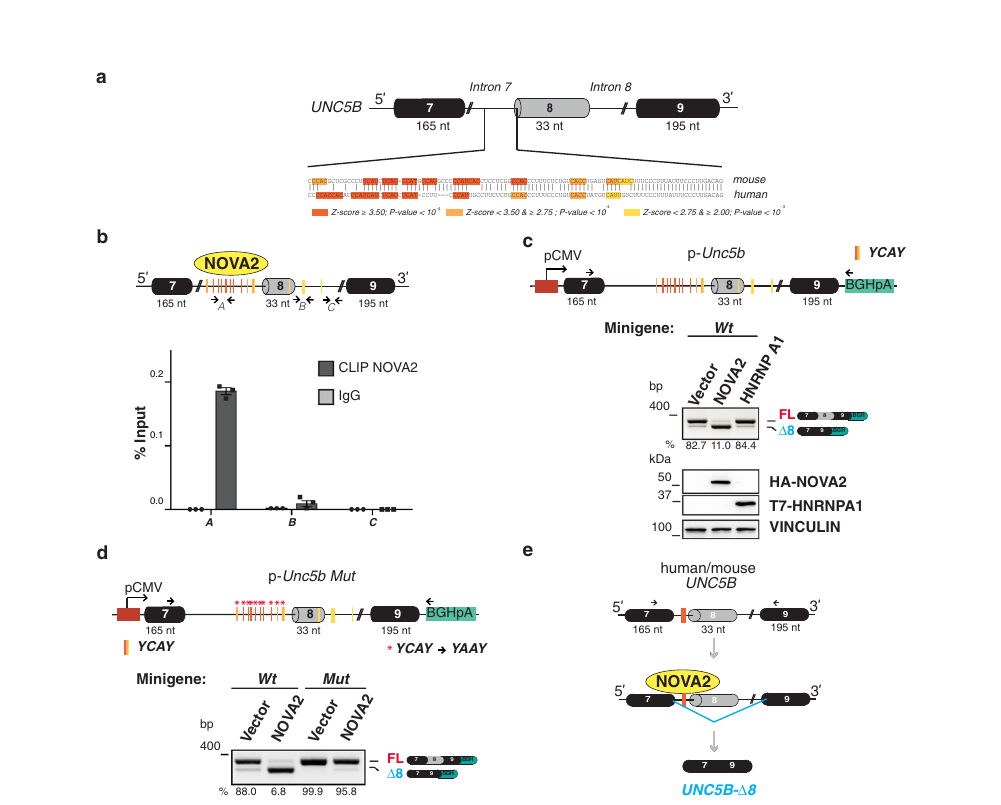
Fig. 2 NOVA2 directly binds to Unc5b pre-mRNA. a Schematic representation of mouse and human UNC5B pre-mRNAs. AS exon 8 in gray. Constitutive exons 7 and 9 in black. Introns 7 and 8 are also indicated (thin lines). YCAY sites, identi fi ed by using the RBPmap tool within 200 nt from the exon – intron junctions, are indicated in orange, pale orange, or yellow bars depending on their Z-score and P values (calculated by RBPmap tool). b Upper: schematic representation of mouse Unc5b as in a . Arrows indicate primers used for RT-qPCR of NOVA2 immunoprecipitated RNAs. Lower: RT-qPCR of NOVA2 CLIP experiments in moEC. Ampli fi cation of immunoprecipitated RNAs with primers annealing to the YCAY cluster in intron 7 (A ) and, as negative controls, within intron 8 ( B and C ). Error bars indicate ±SD calculated from n = 3 independent experiments. c Upper: the mouse Unc5b genomic region encompassing exons 7, 8, and 9, cloned into the pcDNA3.1( + ) vector to generate the p- Unc5b wild-type ( Wt ) minigene. Arrows indicate primers used for splicing analysis of the transcripts generated from the minigene. Boxes = exons; thin lines = introns; pCMV = promoter; BGHpA = polyadenylation sequence. Colored vertical bars as in a . Lower: p- Unc5b Wt co- transfected in moEC with either NOVA2-HA (NOVA2), T7-HNRNPA1 (HNRNPA1), or empty vector (Vector). RT-PCR analysis of p- Unc5b splicing is shown. Ectopic expression of NOVA2 and HNRNPA1 were con fi rmed by immunoblotting with anti-HA and anti-T7 antibodies, respectively. VINCULIN as loading control. d Splicing assay with p- Unc5b Mut in moEC. Red asterisks indicate the mutated NOVA2 binding sites (YCAY repeats were replaced with YAAY). e NOVA2 (yellow circle) promotes UNC5B exon 8 skipping by directly binding to the YCAY cluster (orange bar) located in the intronic region upstream exon 8. The percentage of exon inclusion is shown below each gel. At least three independent biological replicates were analyzed for each the YCAY cluster in Unc5b intron 7 represented a bona fi de RNAs bound by NOVA2 were then analyzed by RT-qPCR with NOVA2 binding site, we performed UV crosslinking and immunoprecipitation (CLIP), which detects direct protein-RNA (primers A) or intron 8 (primers B and C), used as controls interactions in living cells 43 . RNA of UV crosslinked ECs was